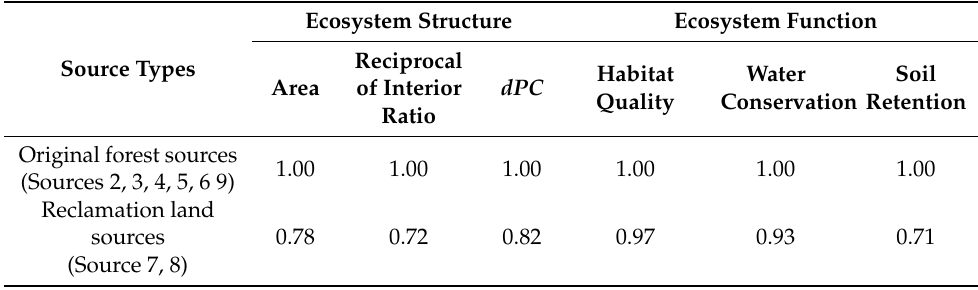
Figure 6. Ecological sources in the study area. Table 1. Mean value of each source indicator based on different source